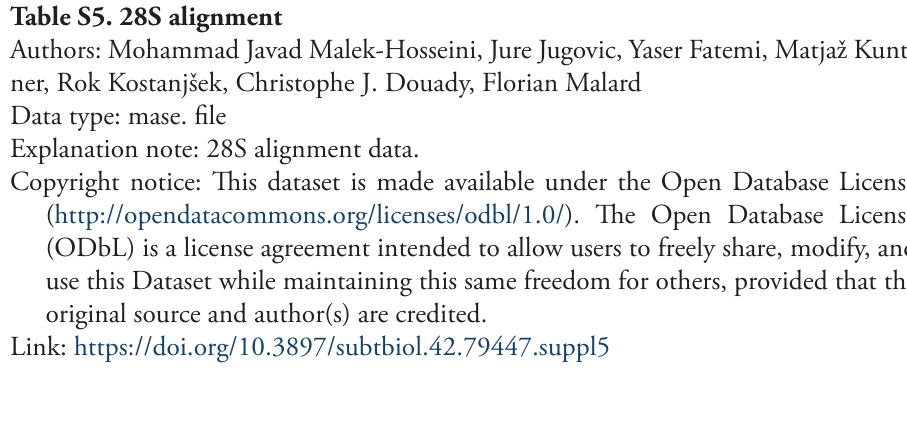
Table S5. 28S alignment